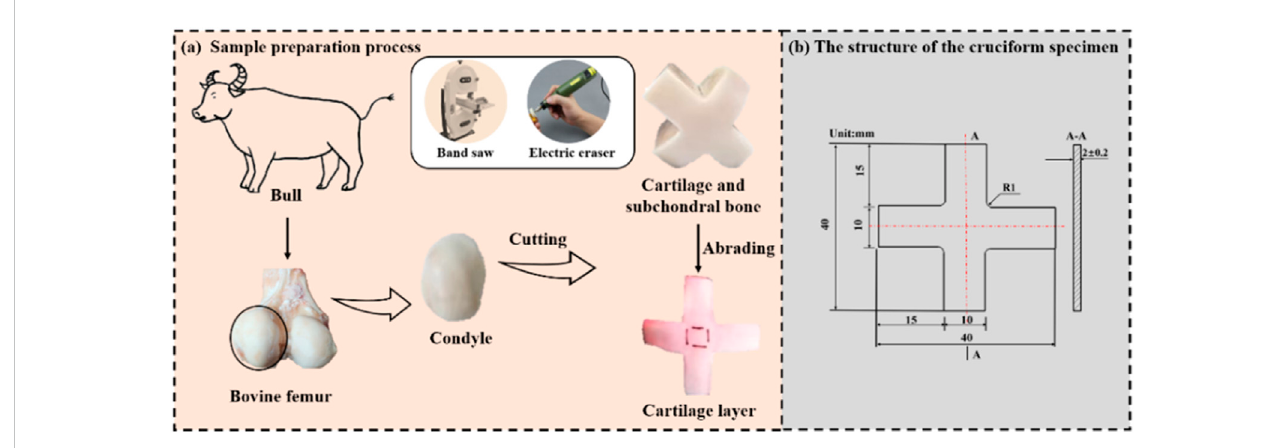
FIGURE 1 (A) Sample preparation process; (B) the structure of the cruciform